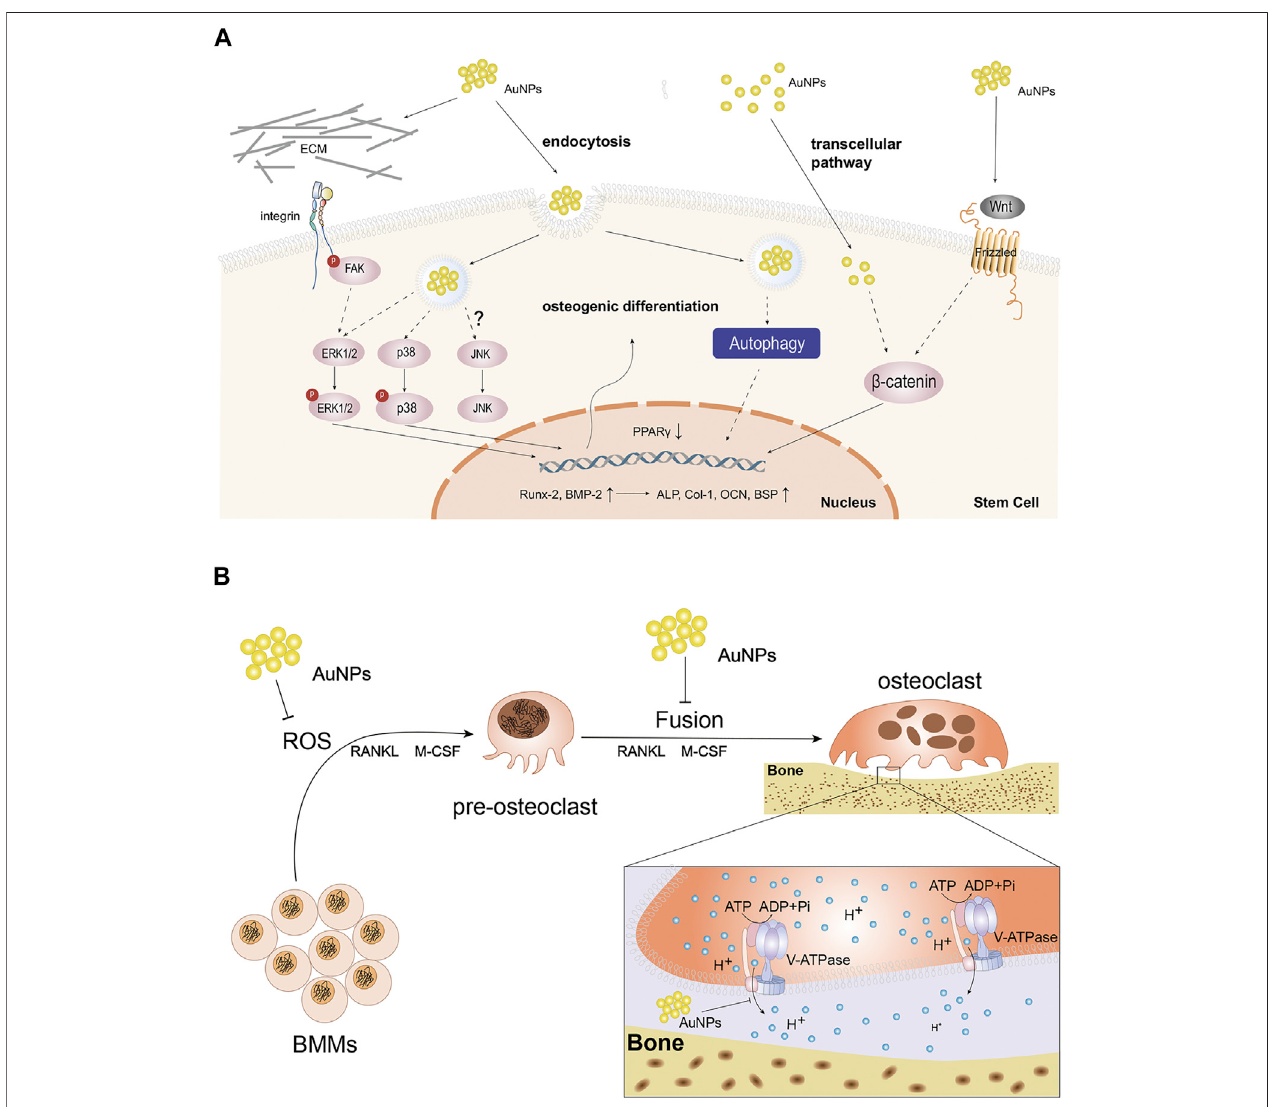
FIGURE1| ThefunctionandmolecularmechanismofAuNPsincells. (A) Schematicdiagramofthepossiblemolecularpathwaysaffectedbytheosteogeniceffects of AuNPs. AuNPs activate integrin and Wnt signaling pathway extracellularly or enter cells through endocytosis and transcelluar pathway. AuNPs up-regulate Runx-2, BMP-2,ALP,Col-1,OCN,BSPandreducePPAR γ toenhanceosteogenicdifferentiationviaERK/MAPK,P38/MAPK,Wnt/ β -cateninsignalingpathwaysandautophagy in osteogenesis-related cells. JNK/MAPK signaling pathway has been not reported so far. (B) Schematic representation of AuNPs disturbing the formation and function of osteoclasts. AuNPs inhibit ROS in BMMs, the fusion of pre-osteoclast cells or the function of V-ATPase in osteoclasts.